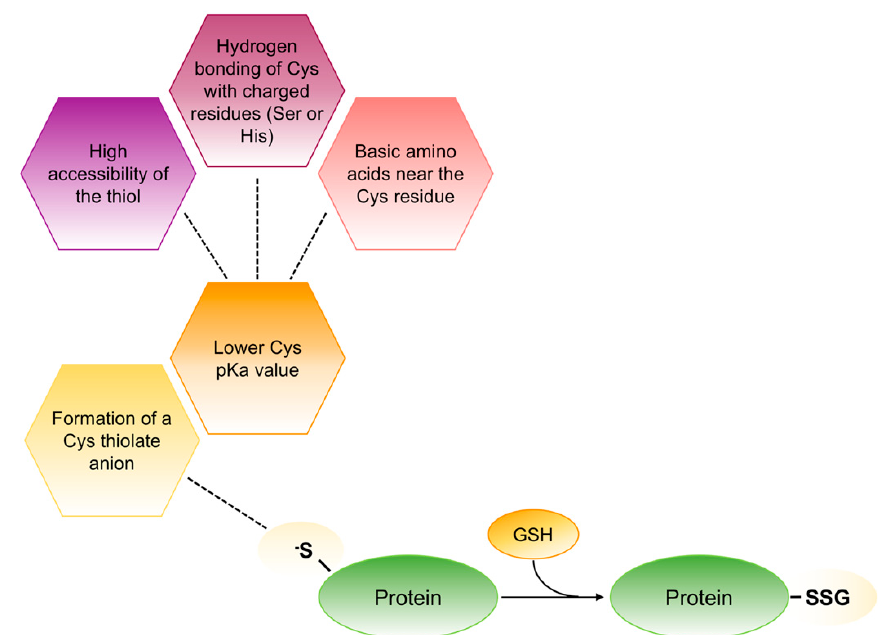
Figure 5. Schematic representation of thiolate anions formation in redox-sensitive proteins. In redox-sensitive proteins different factors contribute to lower the pK a value associated to the thiol side chain of cysteine that forms the thiolate anions (S − ). This anion is stable as such to react with GSH to form mixed disulphides.